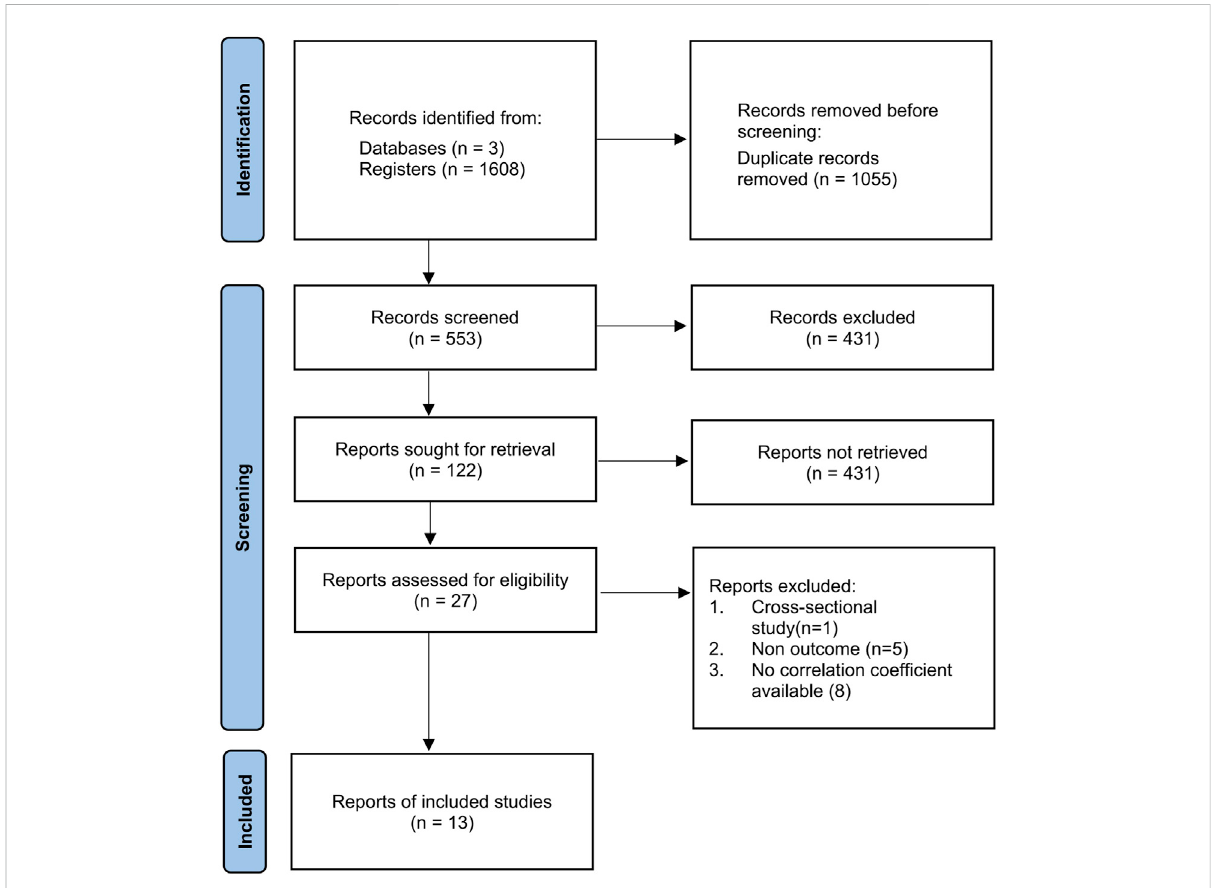
FIGURE 1 PRISMA fl ow diagram showing the selection process of eligible